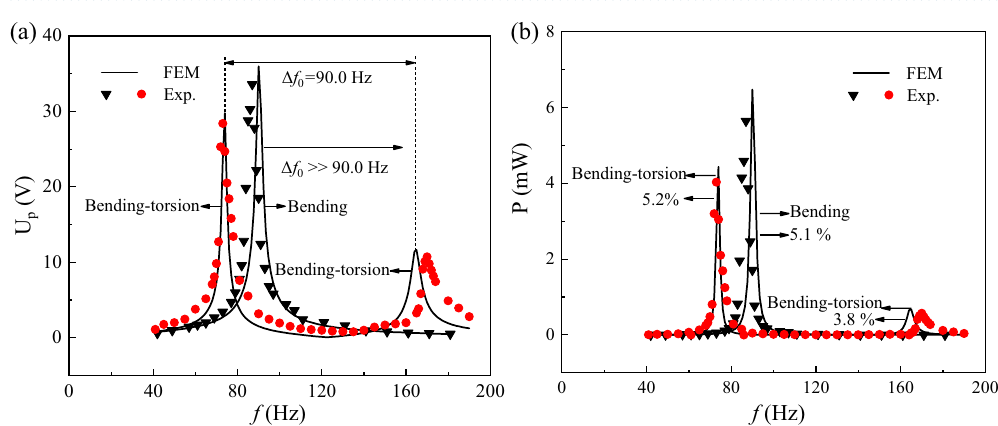
Figure 9. The U p - f ( a ) and P- f ( b ) curves of PEHSCBs undergoing coupled bending-torsion vibrations and bending